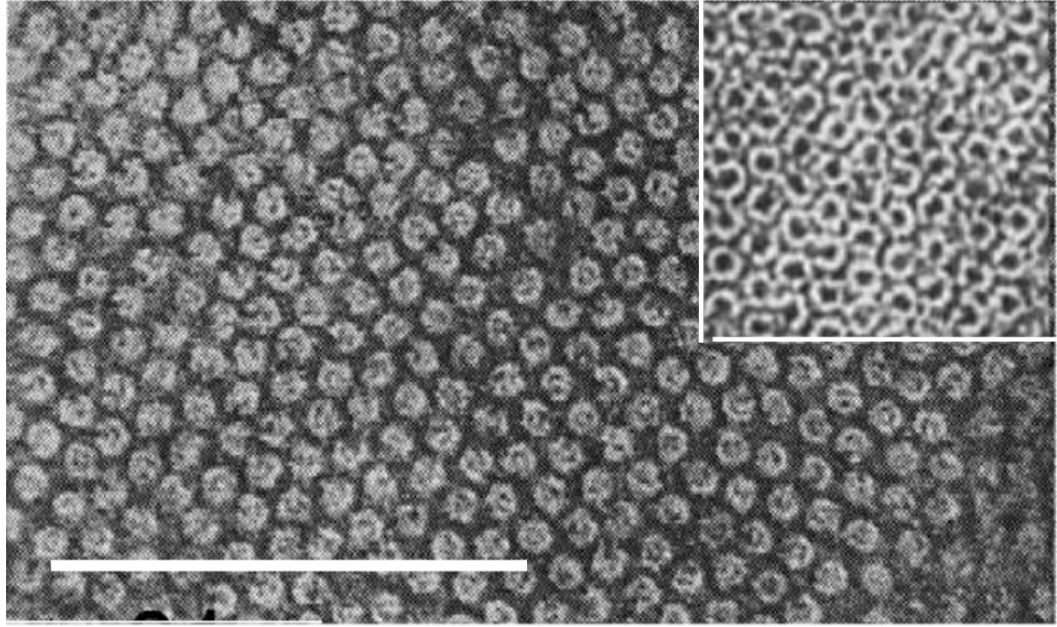
Figure 9. Electron micrograph of a cross-section of fine Merino wool showing the quasi-hexagonal packing of keratin intermediate filaments about 7–10 nm in diameter embedded in an osmiophilic matrix [70]. The magnification bar is 100 nm. The inset (at the same magnification) shows porcupine quill post-stained with potassium permanganate. The KIF have a ring structure. Figure reproduced from [71] with permission of Springer.